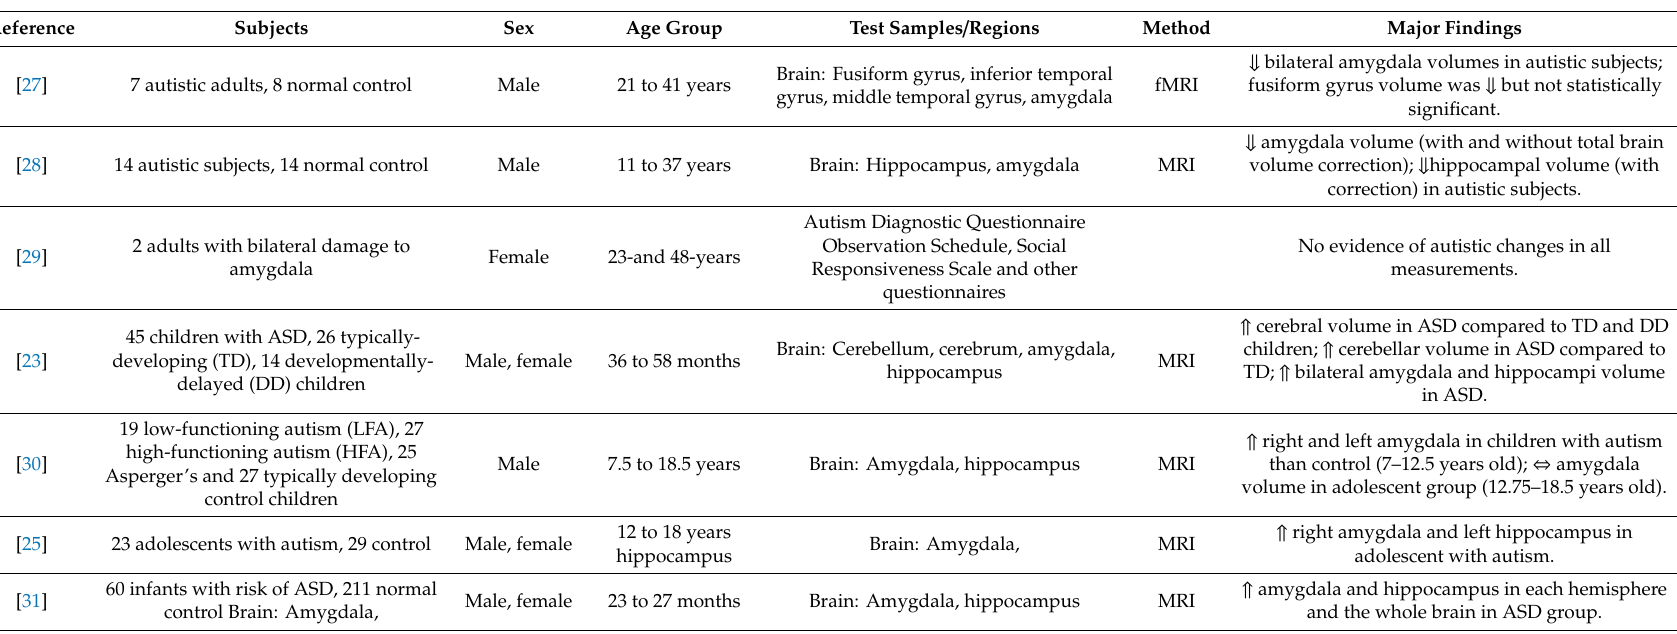
Table 1. Summary of previous studies on brain structure and function abnormalities in autism spectrum disorder